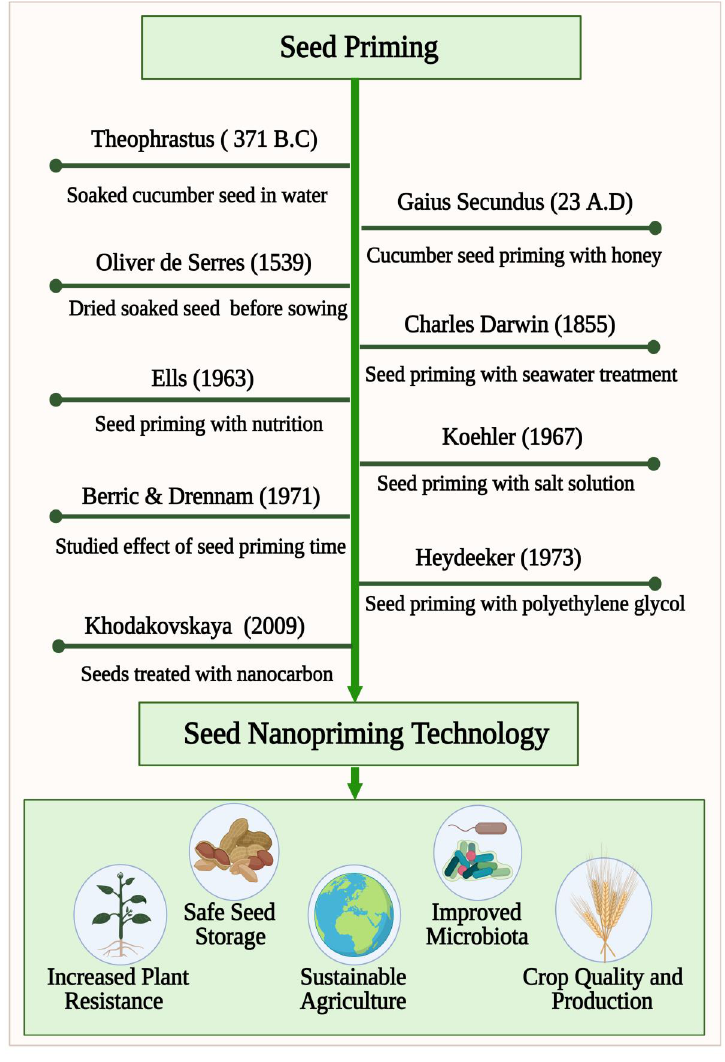
Figure 1. A timeline of seed priming development towards nanopriming technology to improve seed germination. For sustainable food production, nanopriming improves the ability to withstand environmental stressors, improves seed storage, and boosts